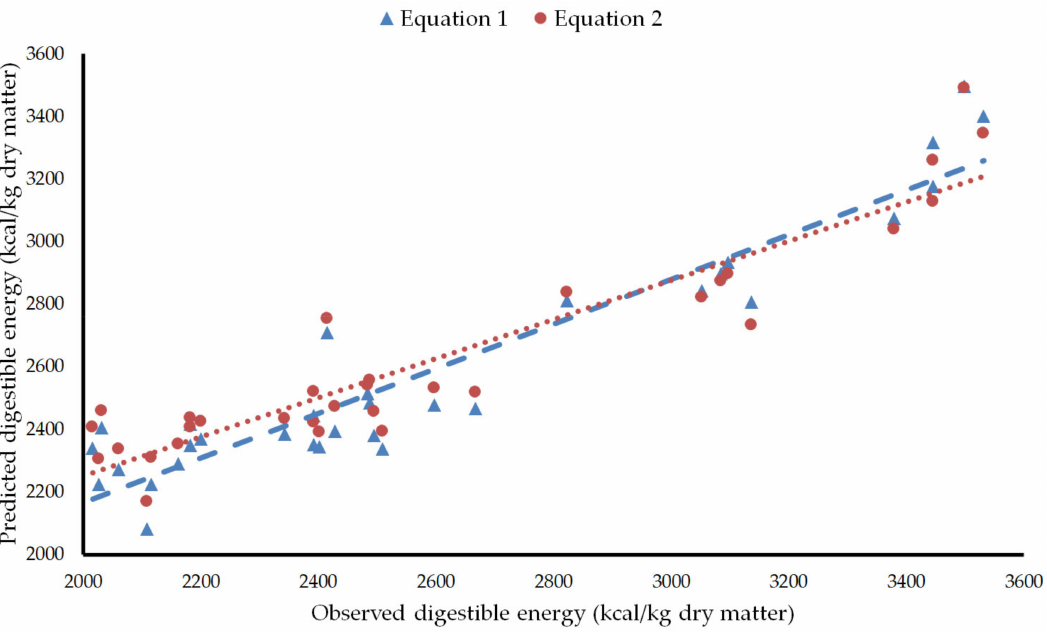
Figure 1. Plot of predicted versus measured values of digestible energy. Equation 1: Equation of N ú ñez-S á nchez et al. [8]. Equation 2: Equation of Zeyner and Kienzle [14] modified as presented in Kienzle and Zeyner [4].